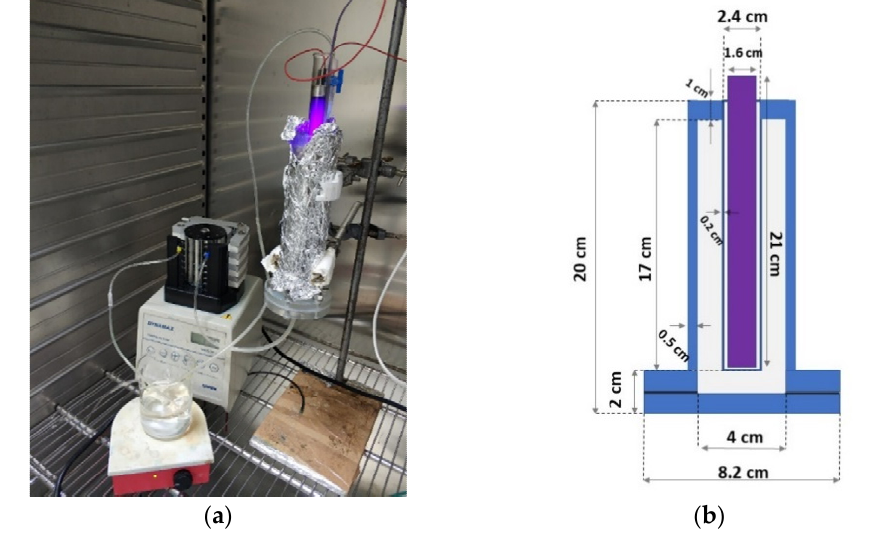
Figure 3. ( a ) Experimental setup of PMMA reactor and ( b ) schematic diagram with dimensions.